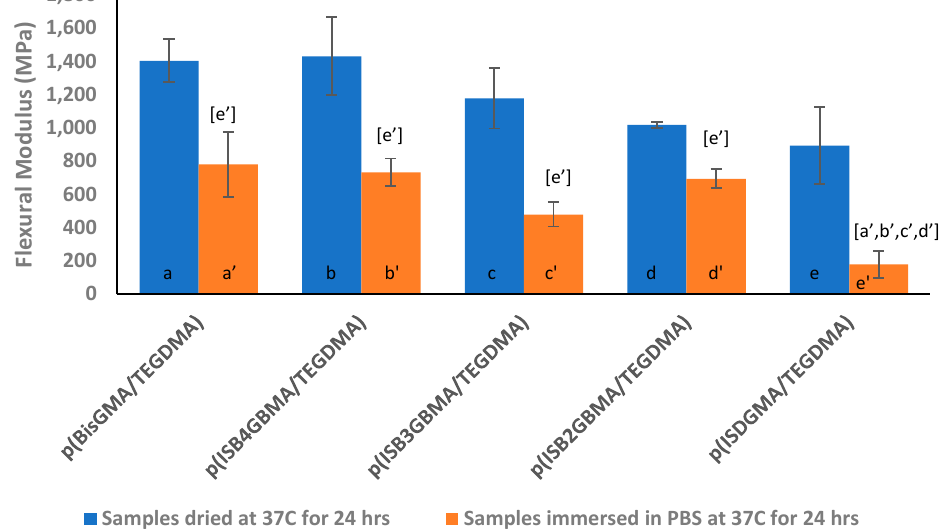
Figure 14. Flexural modulus of p(BisGMA/TEGDMA), p(ISB4GBMA/TEGDMA), p(ISB3GBMA/TEGDMA), p(ISB2GBMA/TEGDMA), and p(ISDGMA/TEGDMA) at 60:40 wt% at RT. Letters indicate statistically significant difference ( p < 0.05) based on group.